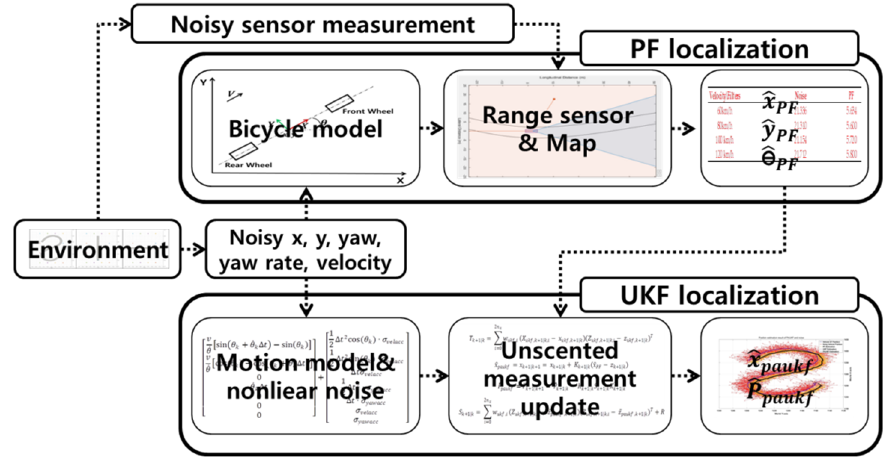
Figure 2. Particle-aided unscented Kalman filter algorithm flowchart.